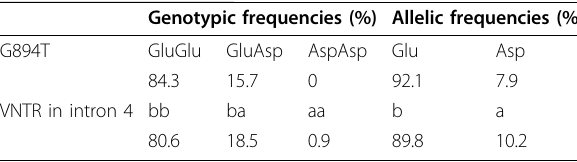
Table 3 Genotypic and allelic frequencies of the